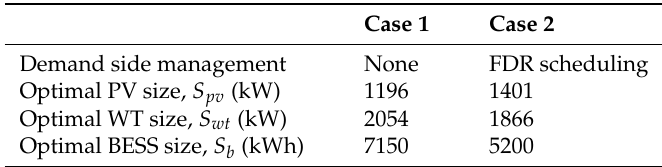
Optimal components size and system configuration comparison without and with